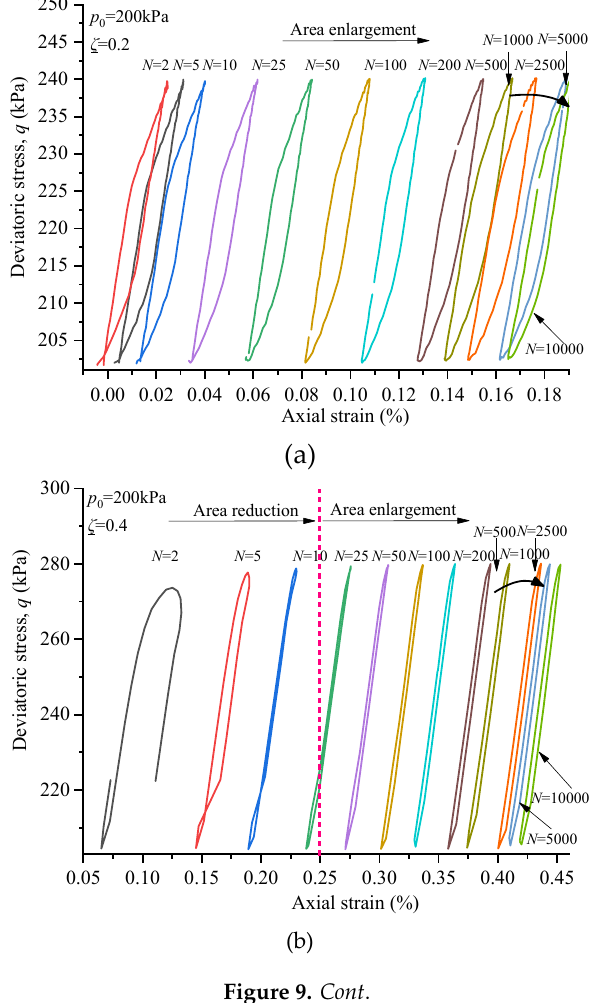
Figure 9 reflects the general evolution trend of the hysteresis loop of coral sand during cyclic loading. The cyclic stress ratio has a significant e ff ect on the dynamic stress-strain relationship of calcareous sand. According to the changing trend of the shape and area of the hysteresis loop with the number of cycles N, the development law of the hysteresis loop under di ff erent cyclic stress ratios can be divided into two types. When the cyclic stress ratio ζ is small ( ζ = 0.2), the hysteresis loop is closed at the beginning, and the area of hysteresis loop increases slightly with the increase of the number of cycles N . At the initial stage of cyclic loading, when the ζ is large ( ζ = 0.4, 0.6 and 1.0), the opening of hysteresis loop is large and its shape is relatively irregular. With the development of cyclic loading, the opening of hysteretic loop tends to close, which is a long ellipse with two pointed ends. As the number of cycles increases, the dynamic strain accumulates, and the hysteresis loop becomes